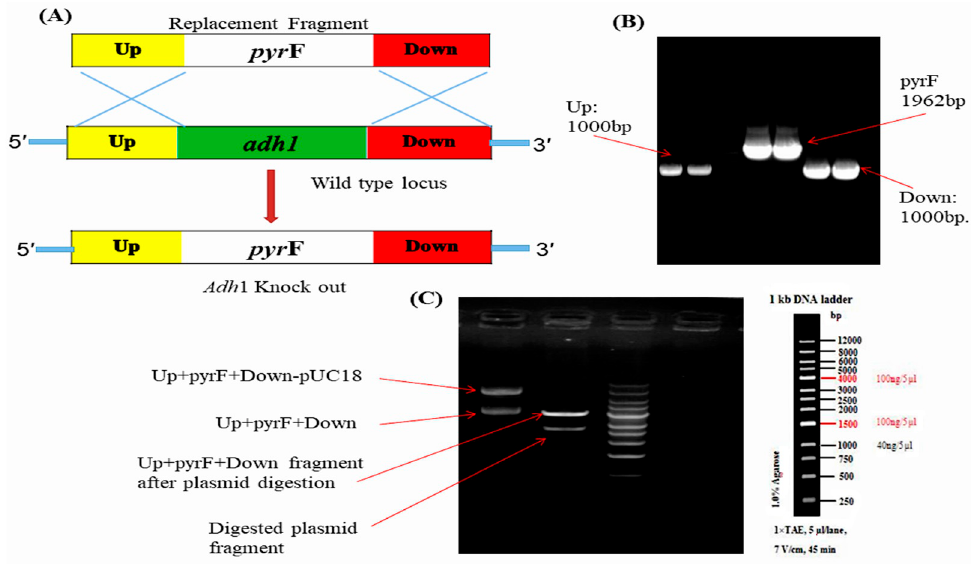
Figure 1. Construction of Knockout (KO) cassette for adh1 ∆ gene deletion in M. circinelloides WJ11 ( A ) Homologous recombination event between replacement fragment and wild type locus; ( B ) PCR amplification of Up, pyr F, down gene from wild type; ( C ) Electrophoresis diagram of Up+pyrF+Down-pUC18 ligation and digestion verification.